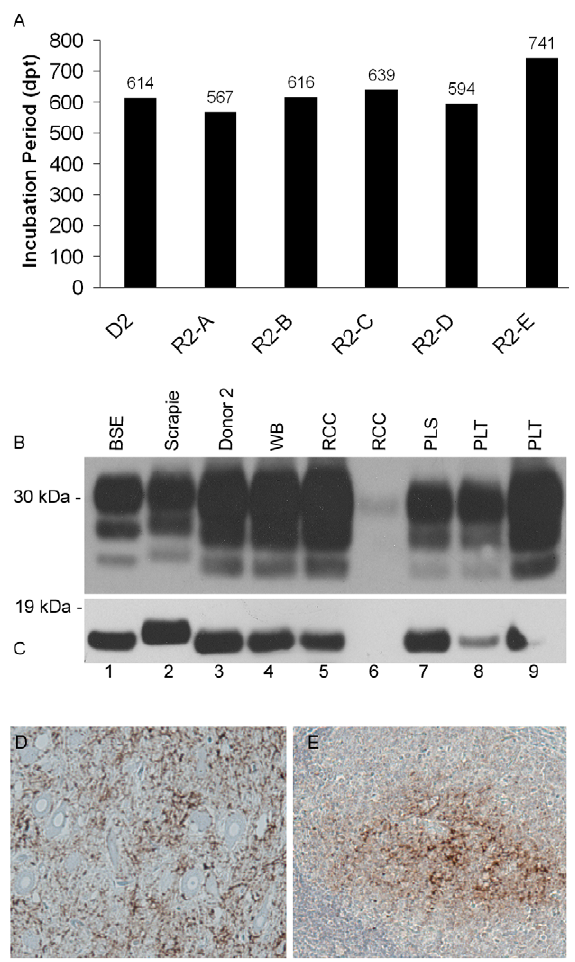
Figure 4. Confirmation of BSE in recipients of non-leucore- duced components. Panel A shows the incubation periods of donor 2 (D2) and its respective transfusion recipients of whole blood (R2-A), red cells (R2-B), buffy coat (R2-C), plasma (R2-D) and platelets (R2-E), whereby the nomenclature used to describe sheep is consistent with that in Table 1. Panel B shows PrP Sc in brain from a donor and a range of transfusion recipients compared to PrP Sc in experimental controls. Lane 1 – BSE control, lane 2 – sheep scrapie control, lane 3 – donor 2, lane 4 whole blood recipient, lanes 5 and 6 – two recipients of red cells, lane 7 – plasma recipient and lanes 8 & 9 – two recipients of platelets. Lane 6 shows detection of low levels of PrP Sc in recipient 7B that received a unit of red cell concentrate and died of intercurrent causes before reaching clinical endpoints. The PrP Sc profile is consistent with that of cattle BSE (lane 1) as expected. These data are confirmed following PNGase F treatment of PrP Sc as shown in panel C. Panels D and E show abnormal prion protein deposition in dorsal motor nuclei of the vagus nerve (DMNV) in brain and tonsil of donor 16, respectively. Tissue sections were stained with